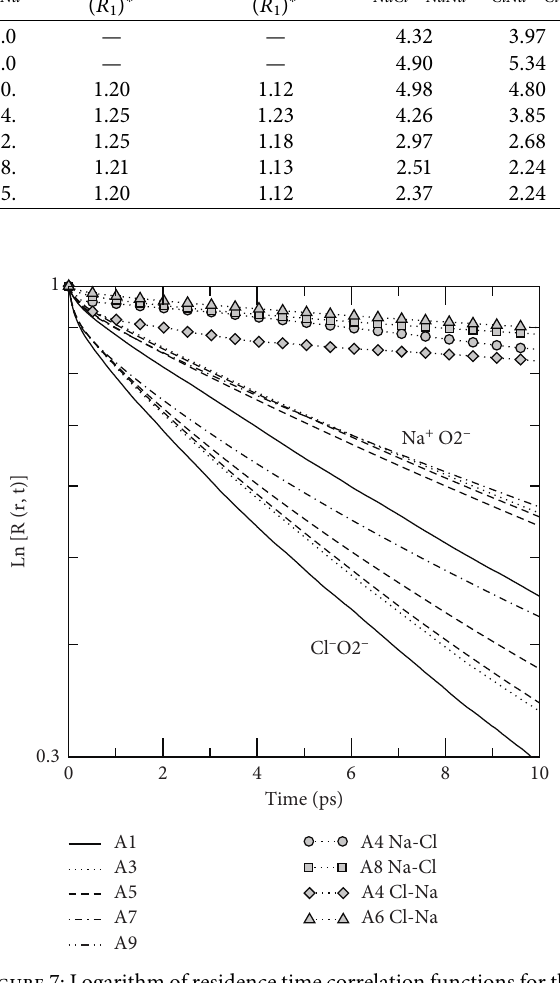
is not included in this study. w